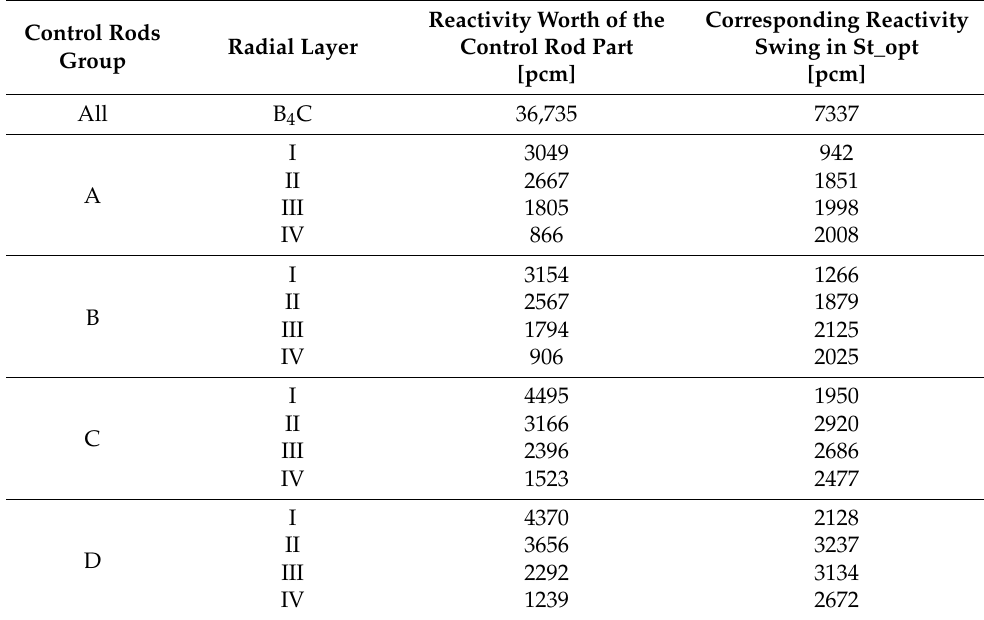
Table 6. The worth of control rod parts and the reactivity swings in